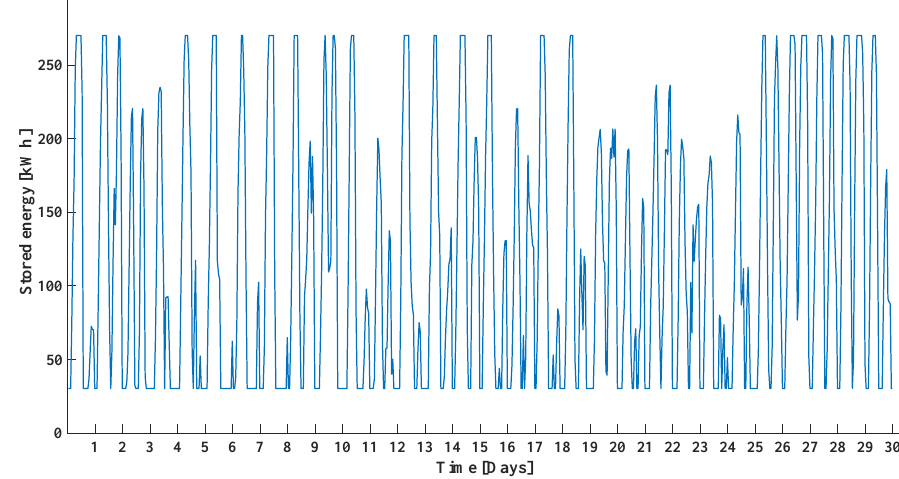
Figure 7. The time evolution of the energy stored in the considered BESS.